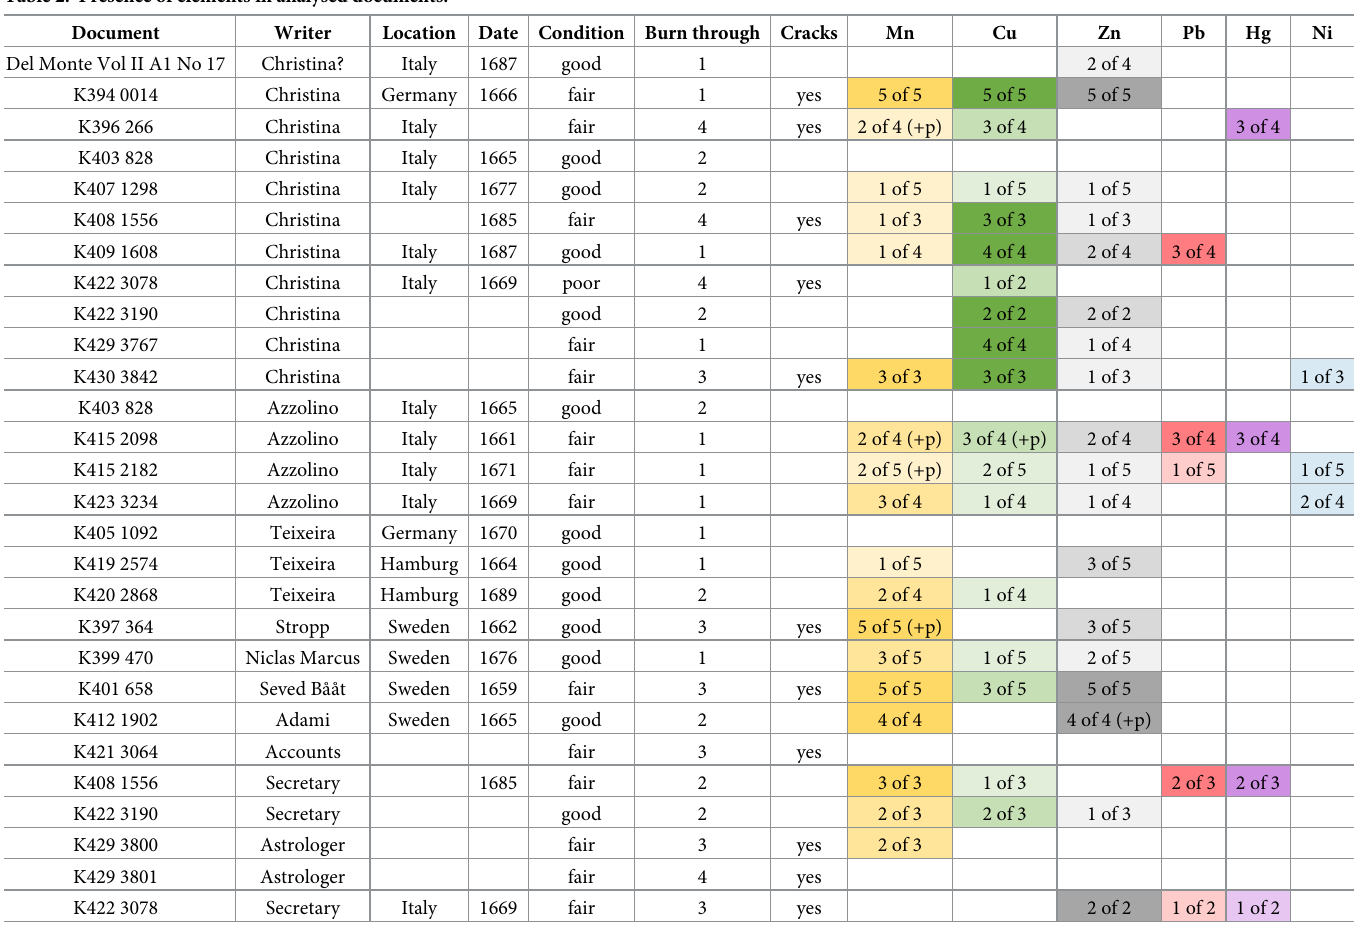
Table 2. Presence of elements in analysed